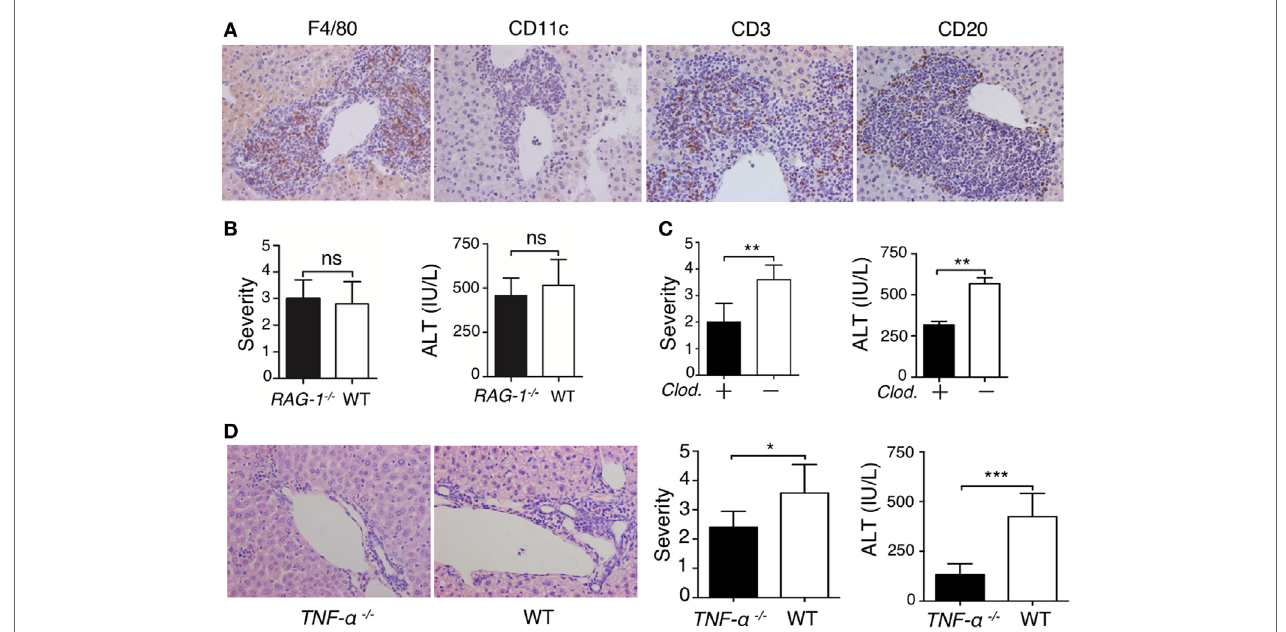
FigUre 3 | Liver inflammation triggered by intrahepatic deposited lupus immunoglobulin G (IgG) depends on macrophages and TNF- α . (a) Immunohistochemistry detected Kupffer cells (F4/80 + ), dendritic cells (CD11c + ), T cells (CD3 + ), and B cells (CD20 + ) in liver sections from lupus-prone mice. The results were from three independent experiments. Original magnification, 200 × (B) Severity of liver inflammation and serum alanine aminotransferase (ALT) level 48 h after intrahepatic injection of systemic lupus erythematosus (SLE)-IgG (200 µg) in RAG-1 –/– and wild-type mice (the result is representative of three independent experiments, n = 5 mice per group/experiment). (c) Severity of liver inflammation and serum ALT level 48 h after intrahepatic injection of SLE-IgG (200 µg) in macrophage-depleted mice with clodronate liposomes ( Clod. )-pretreated and control mice. ** p < 0.01 (the result is representative of three independent experiments, n = 5 mice per